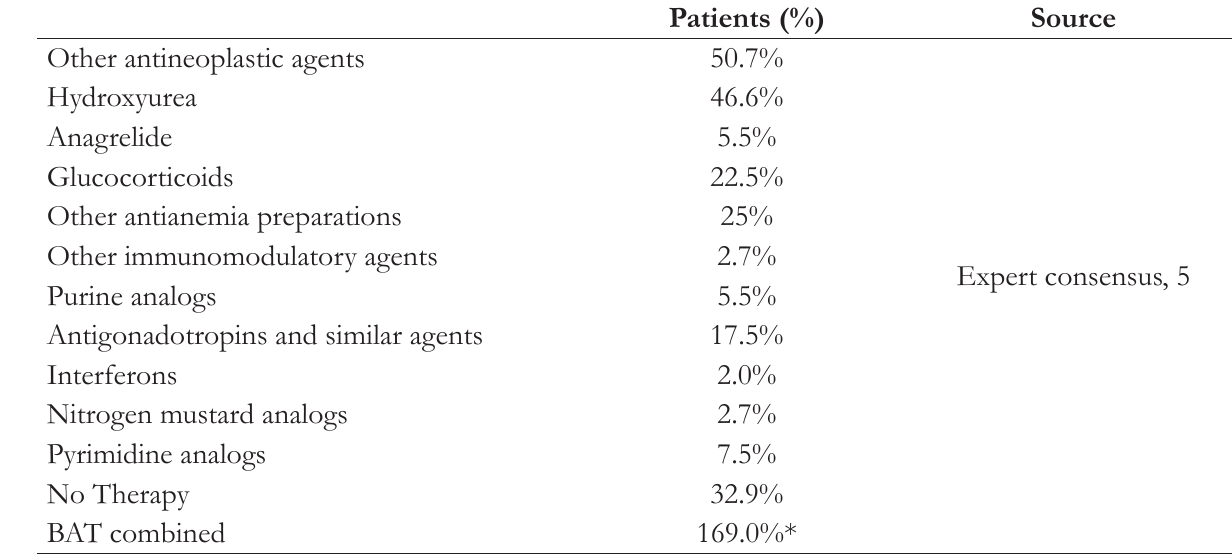
Table 1. BAT Composition Assumed in the